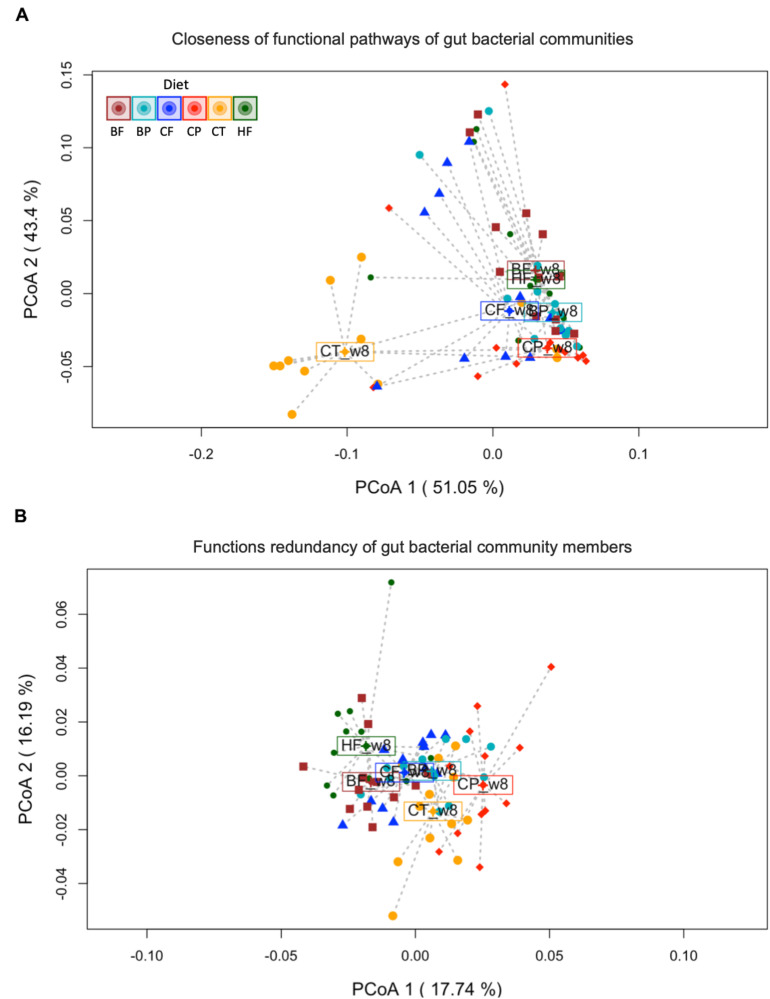
Gut microbiota structure of mice fed polyphenol-rich CP is functionally distinct from HFHS-induced obese mice. (A) Principal Coordinates Analysis (PCoA) on Bray–Curtis metrics indicating the closeness of predicted functions of gut bacterial communities. PERMANOVA R2 0.30065, ***p < 0.001. (B) PCoA on Bray–Curtis metrics of functional redundancy of gut bacterial members according to the type of diet supplementation. Constrained distance-based redundancy shows a clear separation of the functional profiles of mice fed polyphenol-rich whole cranberry powder (CP) and Chow (CT) from HFHS (HF) group. Mice fed the polyphenol-rich whole blueberry powder (BP), blueberry fiber-rich fraction (BF) and cranberry fiber-rich fraction (CF) were confined together slightly separated from HF. PERMANOVA R2 0.27394, ***p < 0.001. Dots represent microbiome samples, colored by diet (n = 12 mice per group). Each centroid (enclosed diet name) is representing the mean functional/redundancy composition of each group.